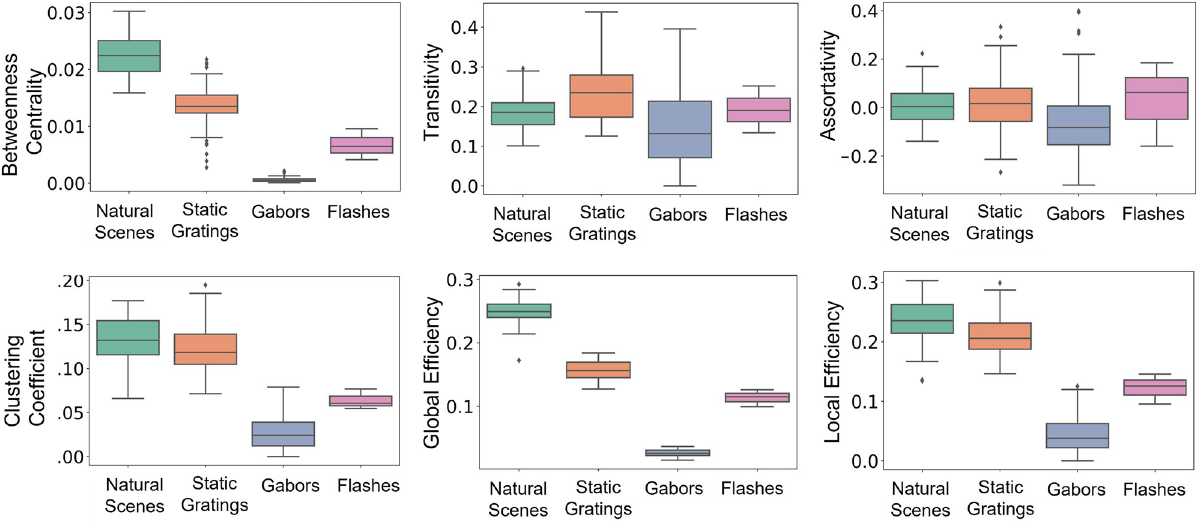
Fig 7. Graphical comparison of estimated CFC over stimuli. This figure compares the distribution of graph measures of CFC obtained by TPC over different stimuli: natural scenes, static gratings, Gabor patches and flashes. The distribution for each graph measure and stimuli is shown by a boxplot.